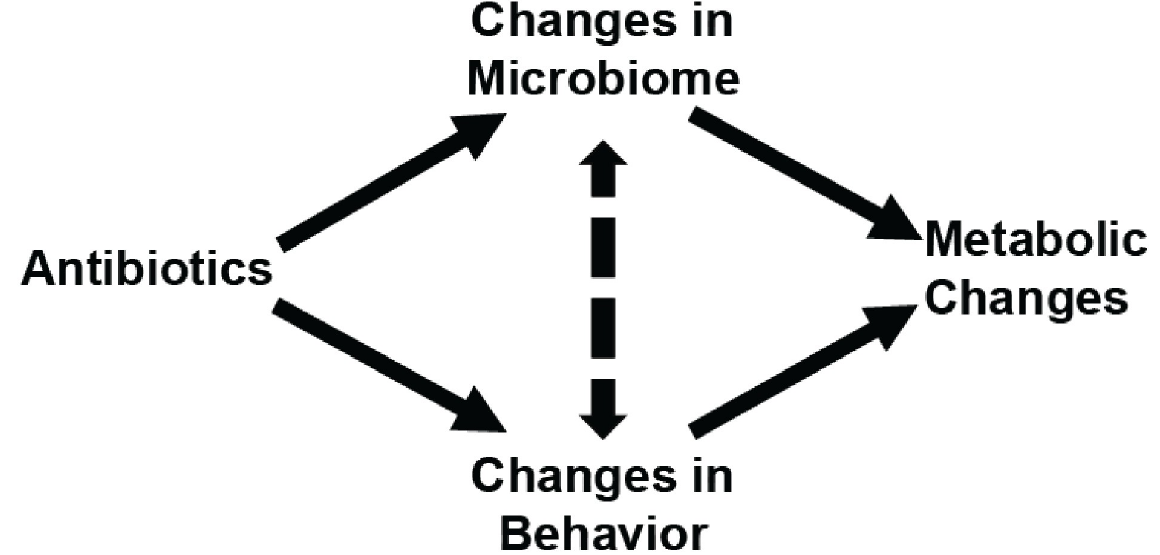
Fig 1. Potential pathways by which antibiotics may lead to metabolic